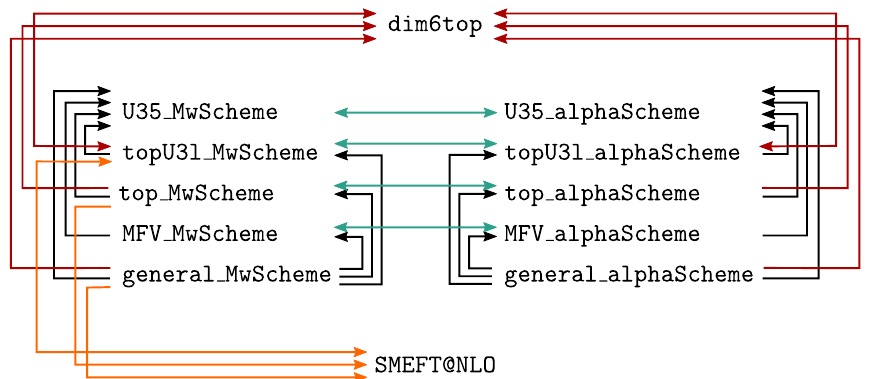
Figure 3 . Diagram of the pairwise comparisons performed to validate the UFO models. The arrow indicates the direction in which the SMEFT parameters are